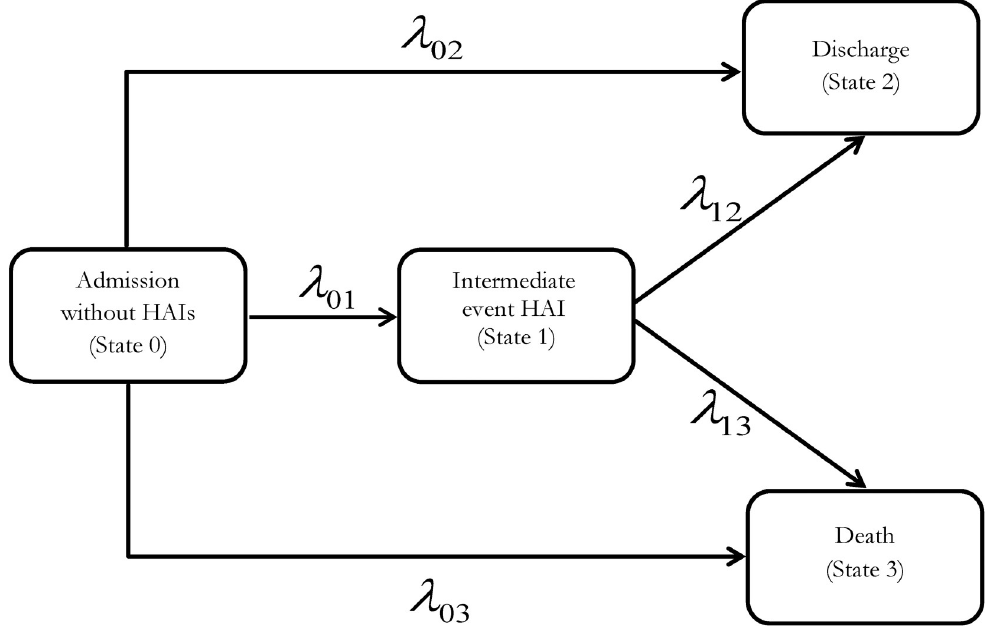
Fig 1. Multistate model with four states. Admission (state 0) is the first state, and all patients entered into the initial state without HAIs. The patient may acquire an HAI and move to intermediate state 1. Discharge (state 2) or death (state 3) indicates the end of